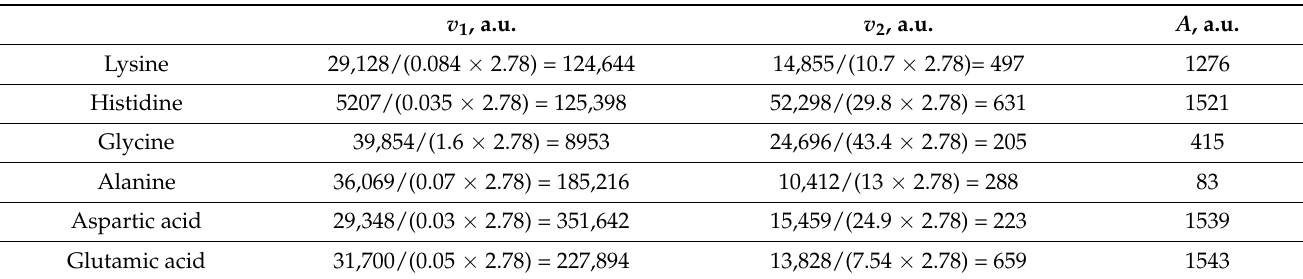
Table 3. The rates v 1 and v 2 of decay of the luminescence intensity and the values of free constants A for suspensions of amino acids in DDW. v 1 , a.u. v 2 , a.u. A ,